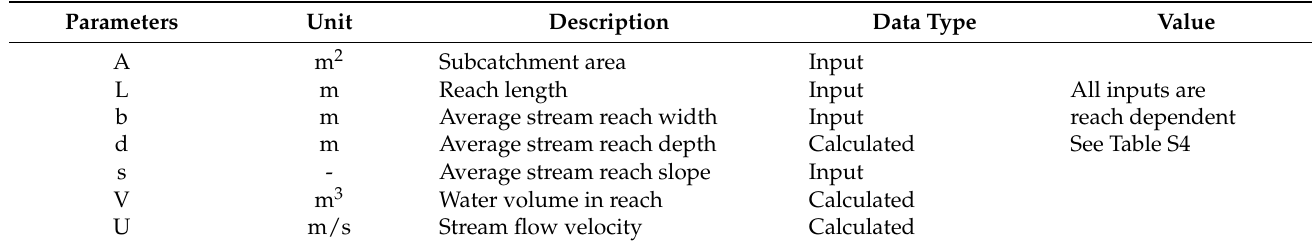
Table A1. Catchment and reach.